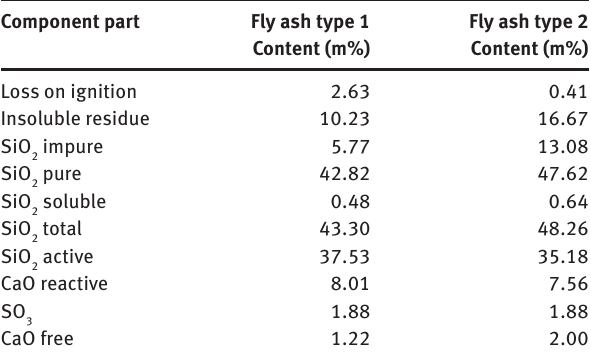
Figure 4 Micro fractography of the sample BI-DT microcrack on the wall of air bubble with ettringite crystals; SEM, SEI.